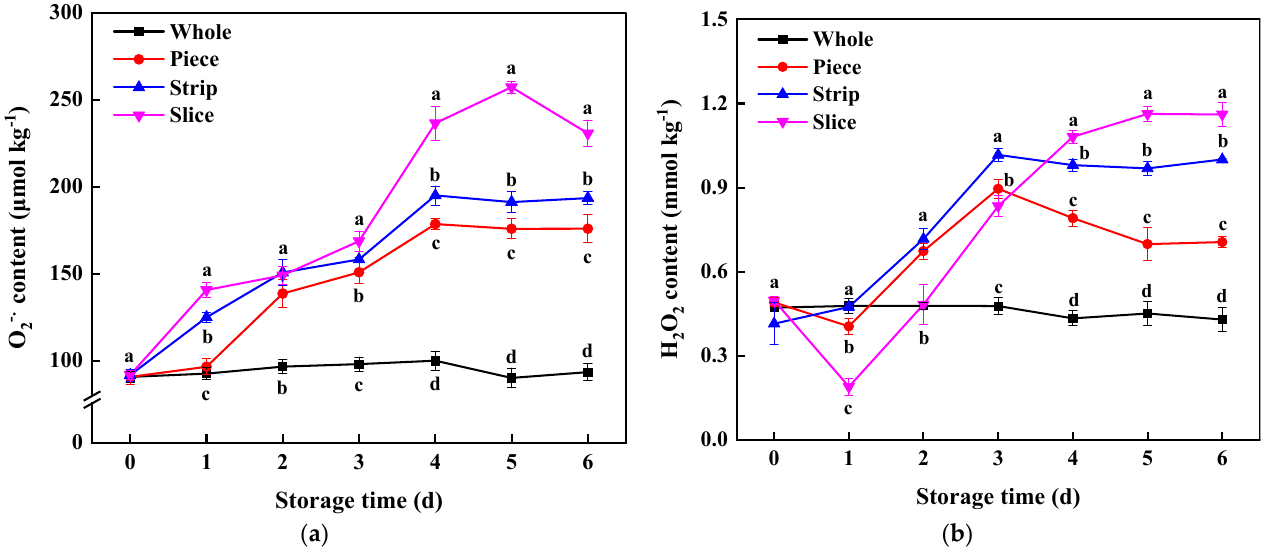
Figure 6. Effect of wounding intensities on O 2 − • ( a ) and H 2 O 2 content ( b ) of fresh-cut pumpkin during storage at 4 °C for 6 days. Vertical bars represent the standard deviation of the mean (n = 3). Different letters indicate significant differences between the groups ( p < 0.05).